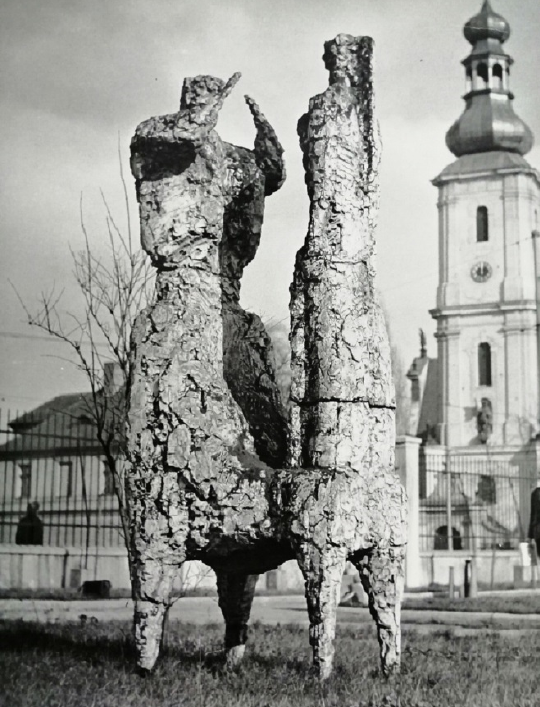
Figure 2. Leon Podsiadły, diploma work (Centaur grający na flecie dla Muzy [Centaur Performing on a Flue for the Muse]), 1958, stone. After: Ośrodek Dokumentacji Sztuki Akademii Sztuk Pięknych im. Eugeniusza Gepperta [the E. Geppert Academy of Art and Design] in Wrocław. Photo used with the permission of the artist’s family.